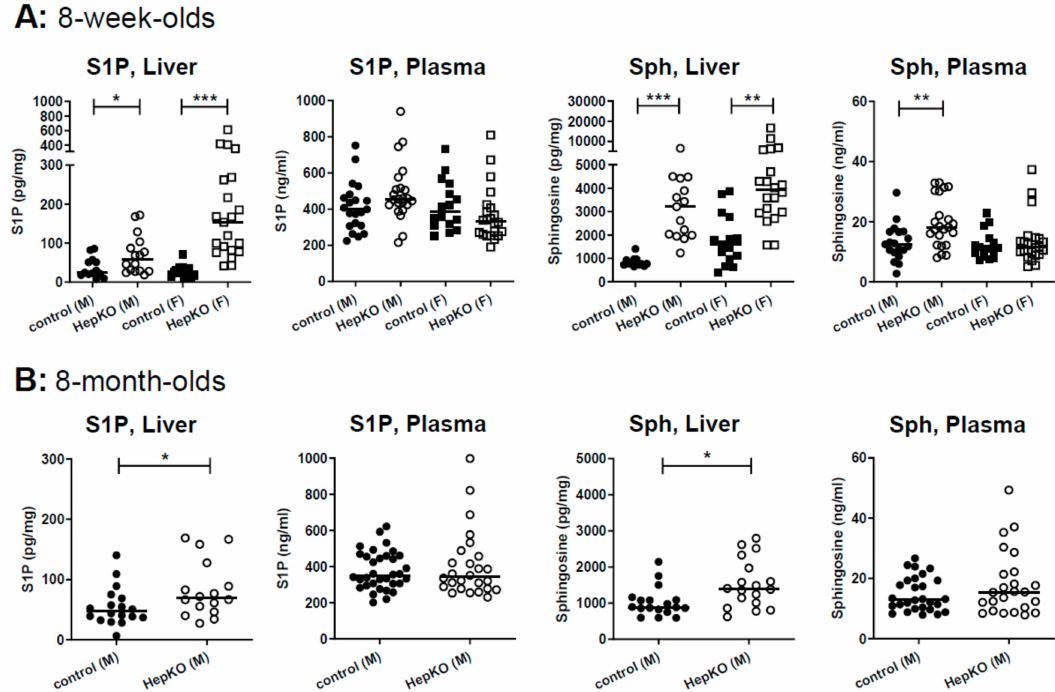
Figure 2. Levels of S1P and sphingosine in liver and plasma of Sgpl1 HepKO mice. Levels of S1P and sphingosine (Sph) were measured by LC-MS/MS in liver and plasma of Sgpl1 control and Sgpl1 HepKO mice at the age of 8 weeks ( A ; n = 13–23) or 8 months ( B ; n = 16–34). Shown are values from individual mice and their median. * p < 0.05, ** p < 0.01, *** p < 0.001 in two-tailed Student’s t -test with Welch’s